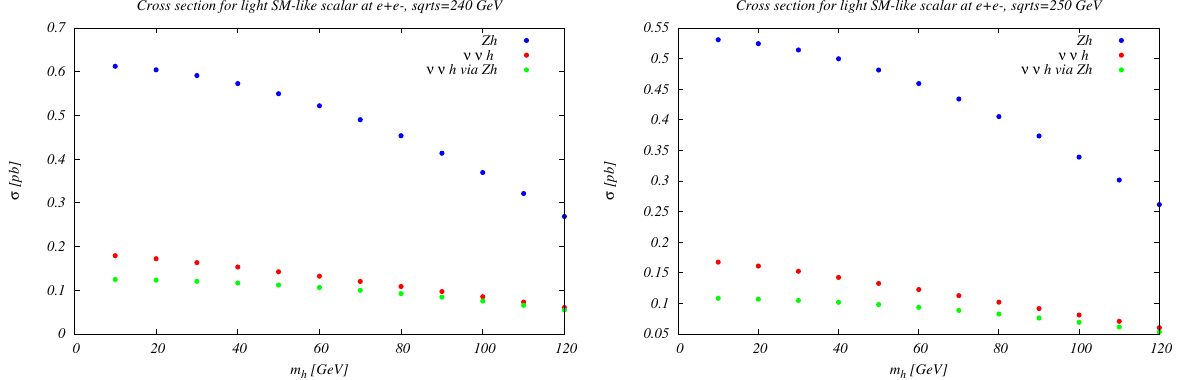
Figure 9. Leading order production cross sections for Z h and h ν (cid:96) ¯ ν (cid:96) production at an e + e − collider with a com energy of 240 GeV( left ) and 250 GeV ( right ) using Madgraph5 for an SM-like scalar h. Shown is also the contribution of Z h to ν (cid:96) ¯ ν (cid:96) h using a factorized approach for the Z decay.